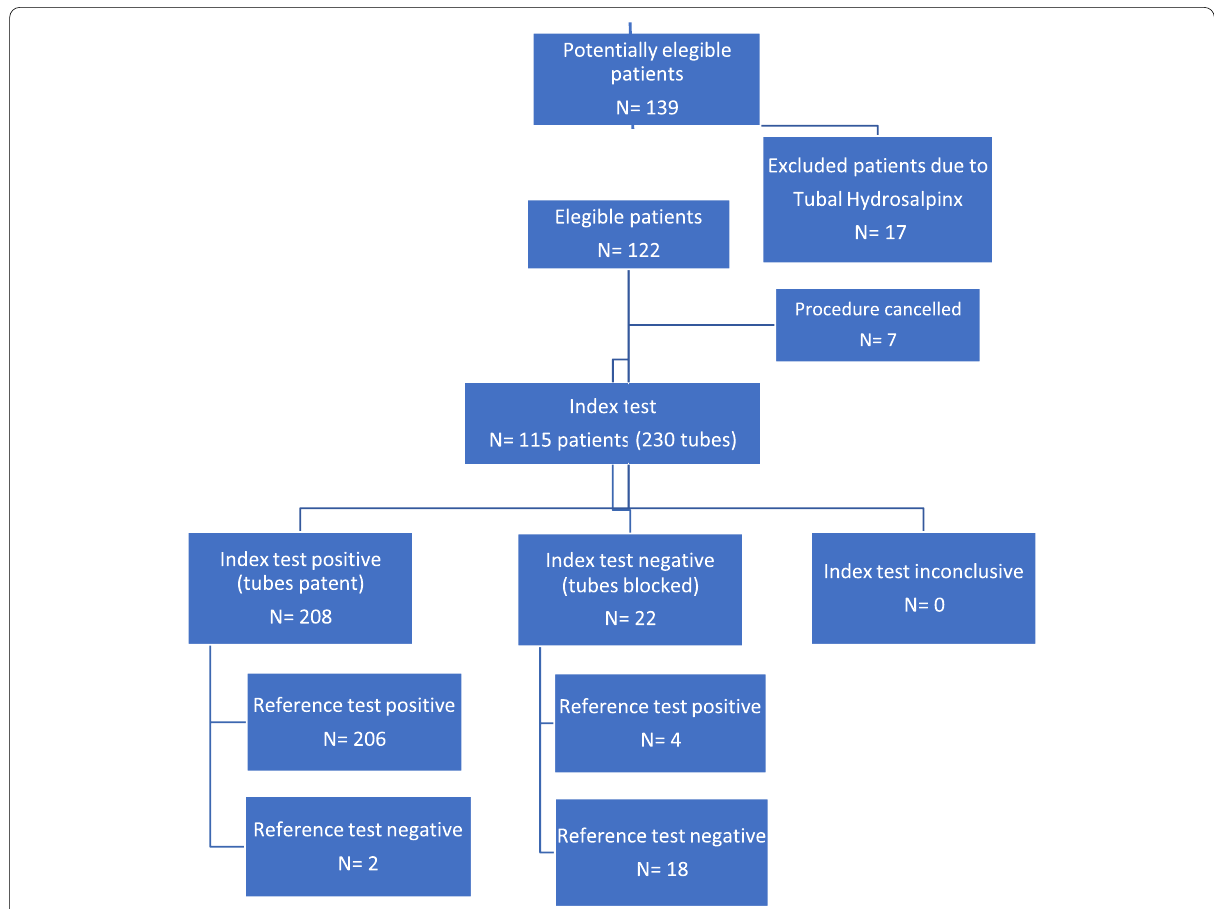
Fig. 3 Standard for the Reporting of Diagnostic Accuracy Studies (STARD) flow diagram